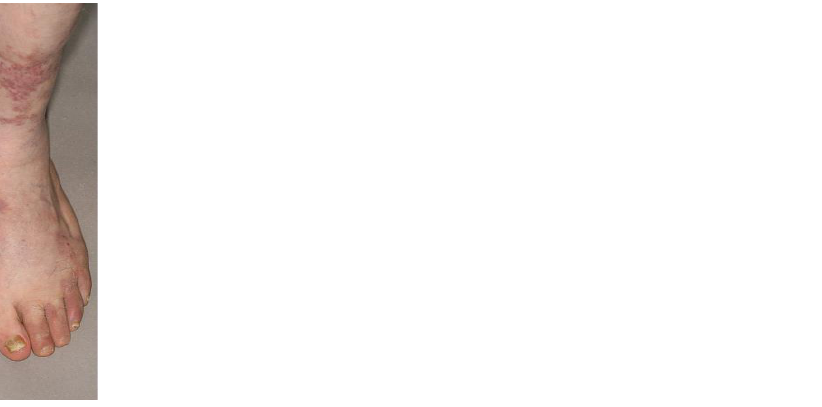
Figure 1. Example of a patient with classic KS with cutaneous macular extension in the lower limbs, not detected by FDG PET/CT.